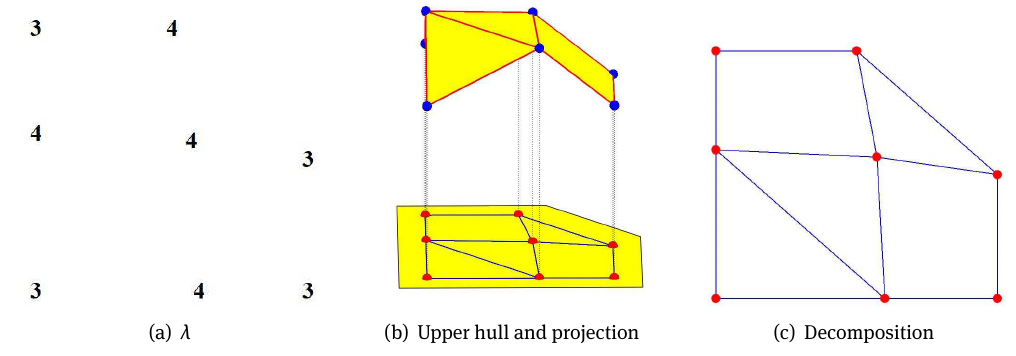
Figure 15: Regular